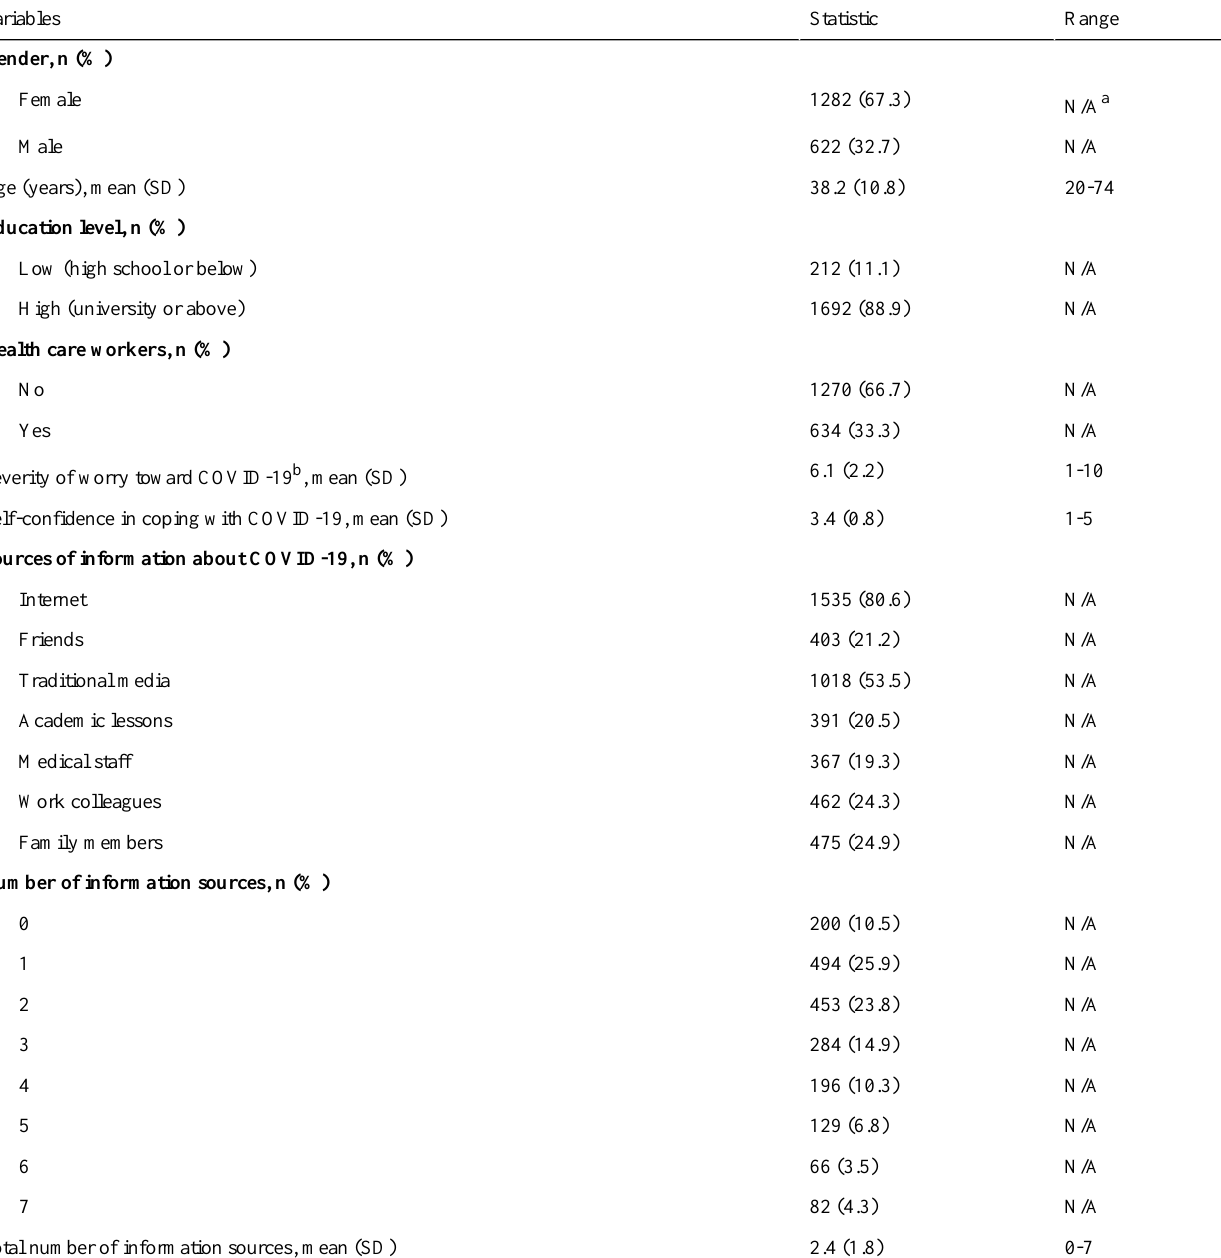
Table 1. Descriptive statistics for participants’ (N=1904) demographic characteristics, worry toward COVID-19, self-confidence in coping with COVID-19, and COVID-19 information